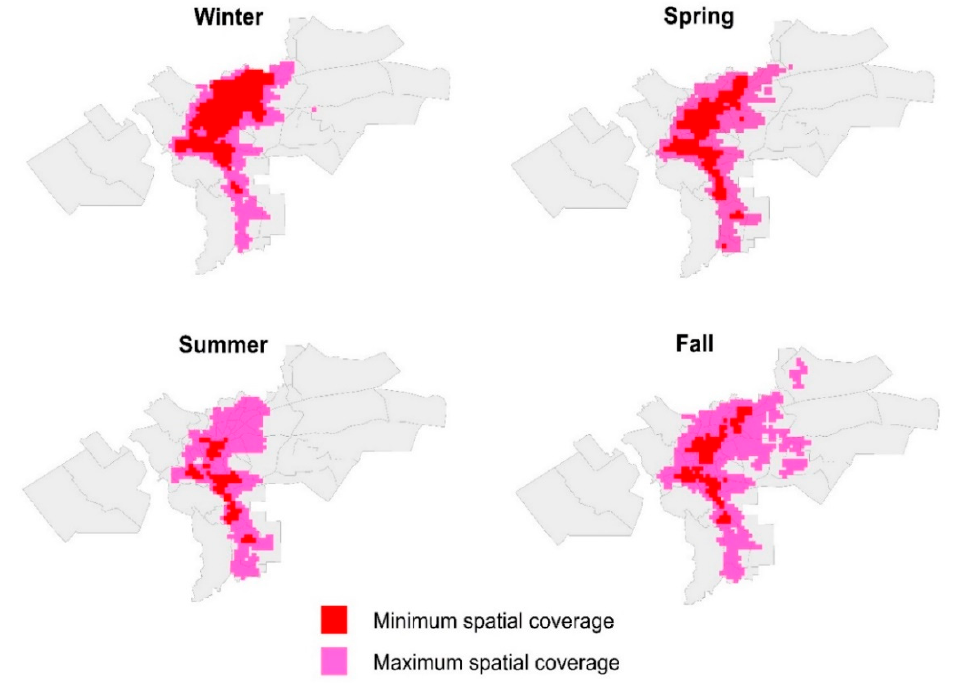
Figure 7. The minimum and maximum spatial extents of SUHI over Greater Cairo for the period 2003–